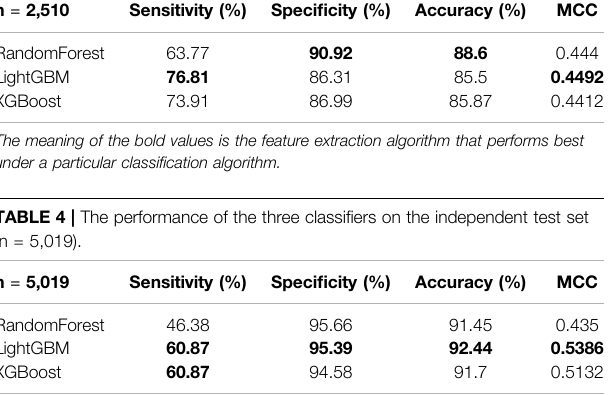
TABLE 3 | The performance of the three classi fi ers on the independent test set (n (cid:1) 2,510). n = 2,510